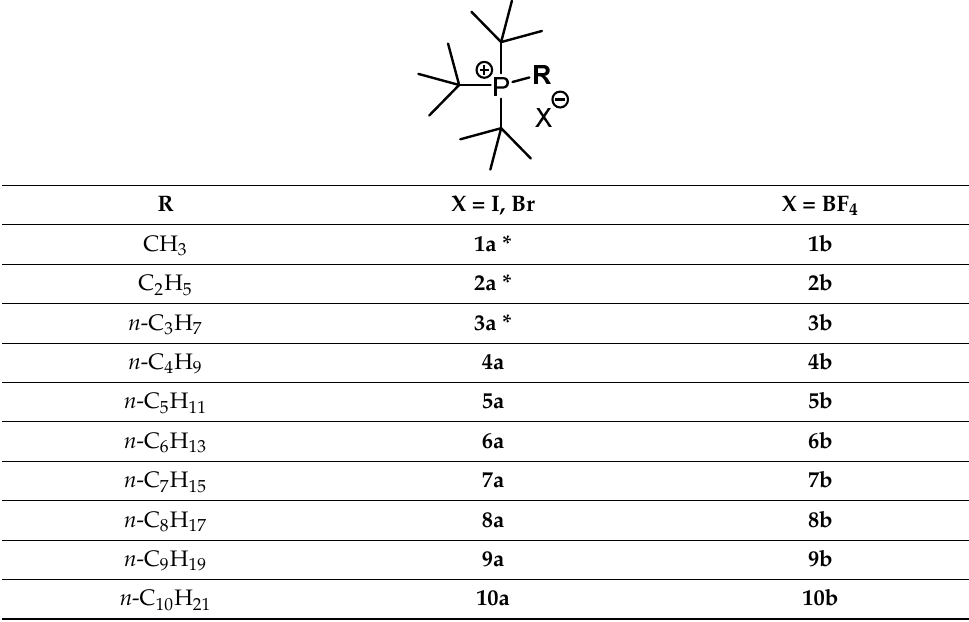
Table 1. The structure of the QPSs under investigation.